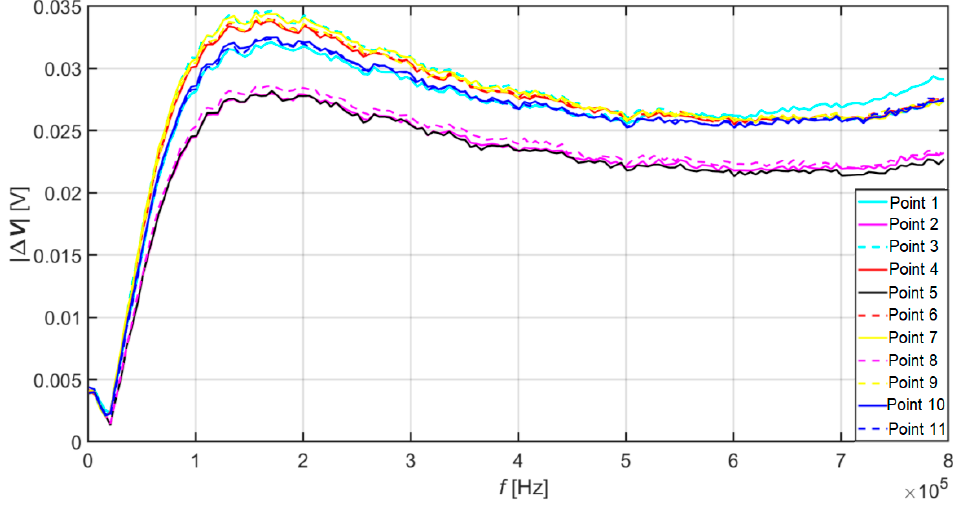
Figure 11. Graph of the absolute value of the voltage phasor of Specimen 7 corrosion crack.